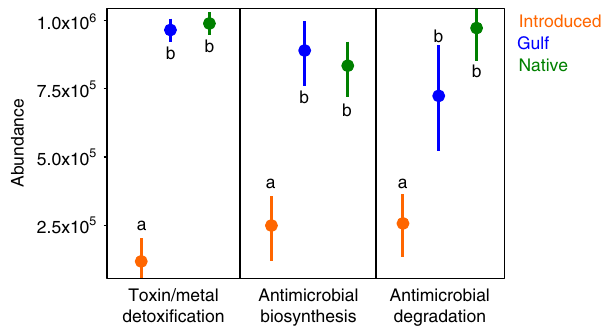
Fig. 4 Abundance of KEGG pathways potentially associated with plant – microbe interactions in the rhizosphere soils of Introduced, Gulf, and Native lineages. In each of the three pathways, data are the mean ± standard error of the mean and different letters denote signi fi cantly different means within each pathway. The abundance of each pathway was signi fi cantly lower in the Introduced lineage rhizosphere microbial communites than in those communities associated with the Gulf and Native lineages. Toxin/metal detoxi fi cation: ANOVA, F 2,75 = 47.56, p < 0.001; antimicrobial biosynthesis: ANOVA, F 2,75 = 35.23, p < 0.001; antimicrobial degradation: ANOVA, F 2,75 = 29.33, p < 0.001)